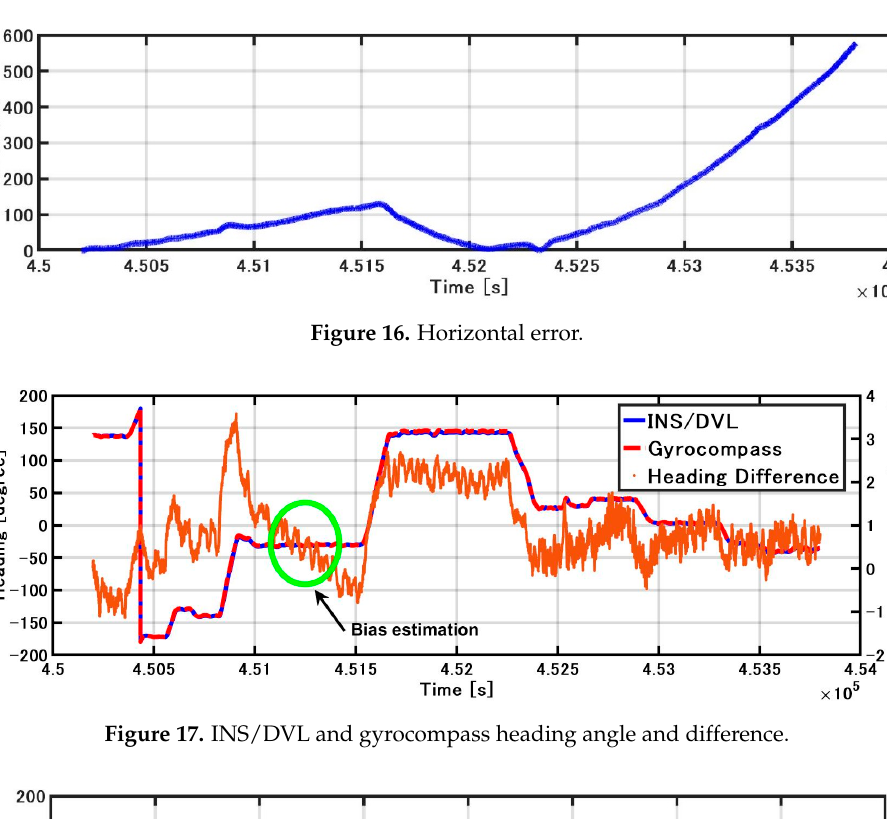
Figure 15. Trajectory with latitude and longitude.